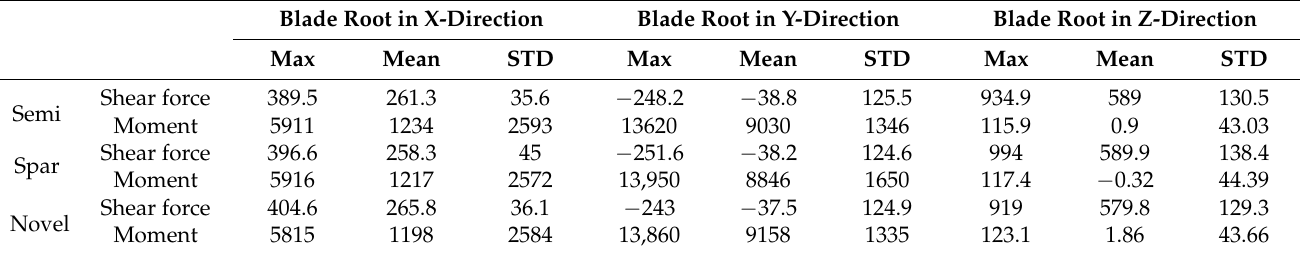
Table 10. Blade root load